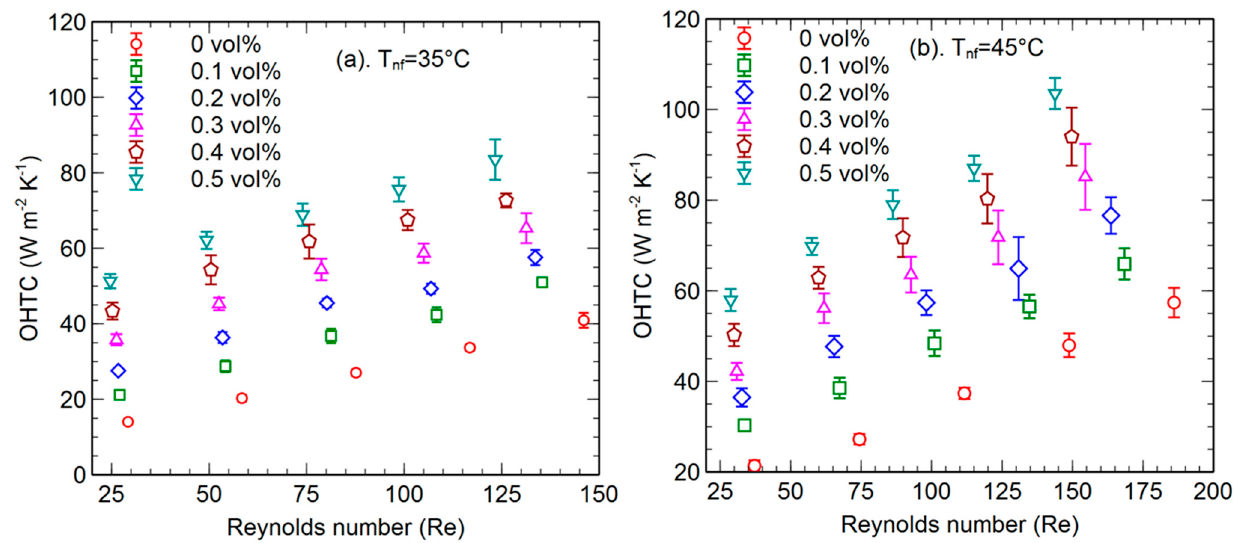
Figure 9. OHTC with respect to Re for various GnP loadings at 5 m/s [108].